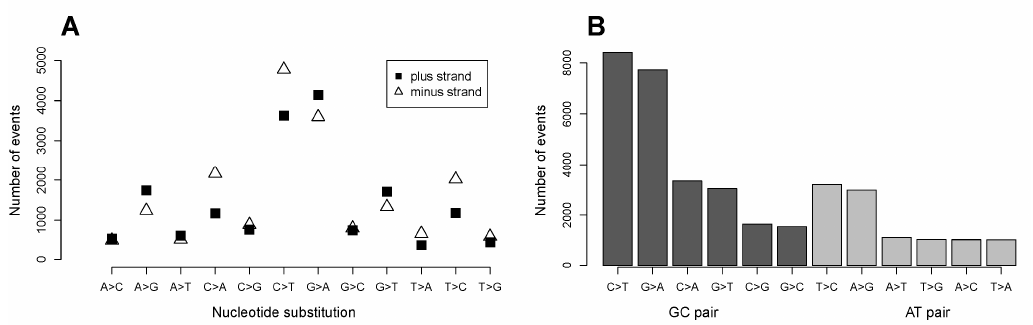
Figure 1. Single nucleotide substitutions in the Cancer Cell Line Encyclopedia (CCLE) database. ( A ) Nucleotide substitutions in the coding and noncoding strands; circa 17,000 substitutions on the coding strand and ca. 19,000 substitutions on the noncoding strand; and ( B ) Difference in numbers of mutations between the GC and AT pairs of nucleotides. The graph comprises the data from the both coding and noncoding strands.